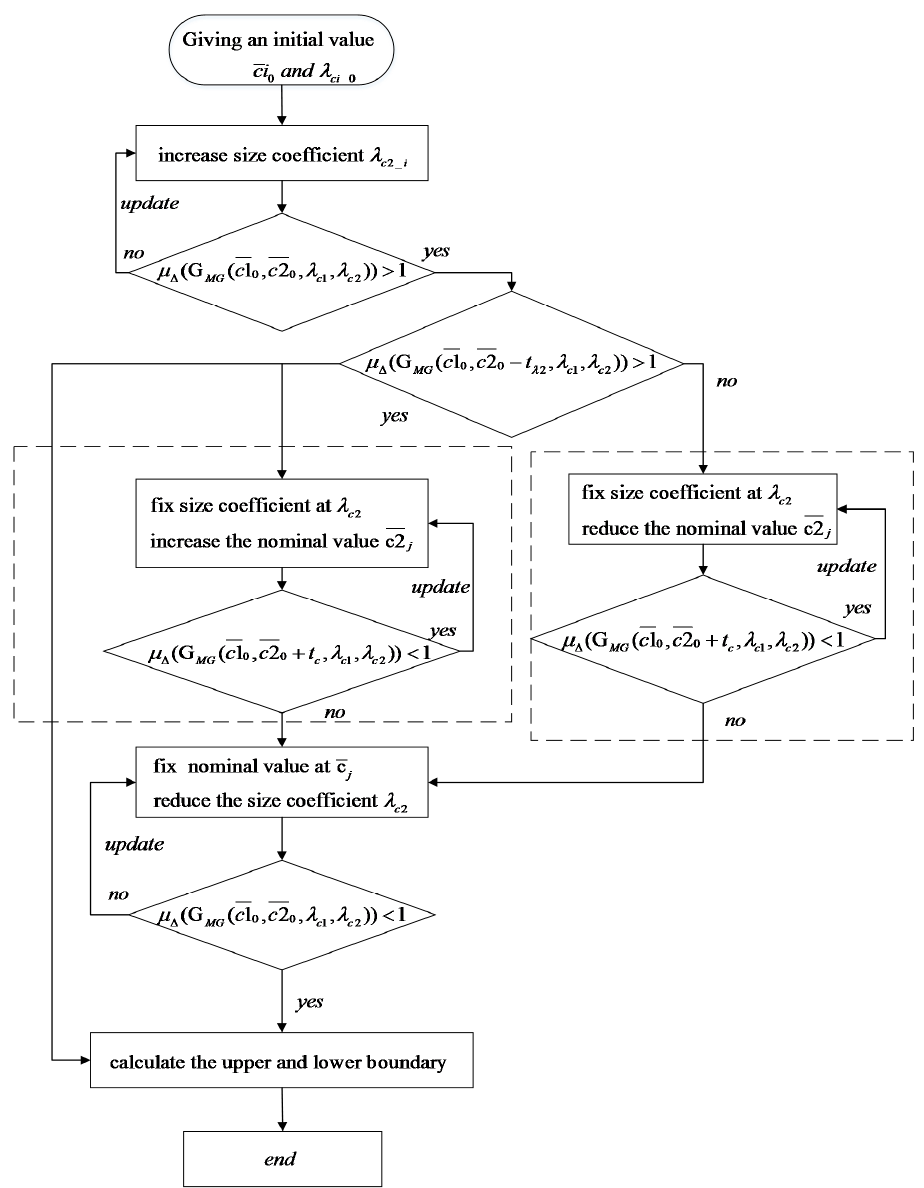
Figure 11. Algorithm for identifying the bounds of multiple uncertainty parameters.